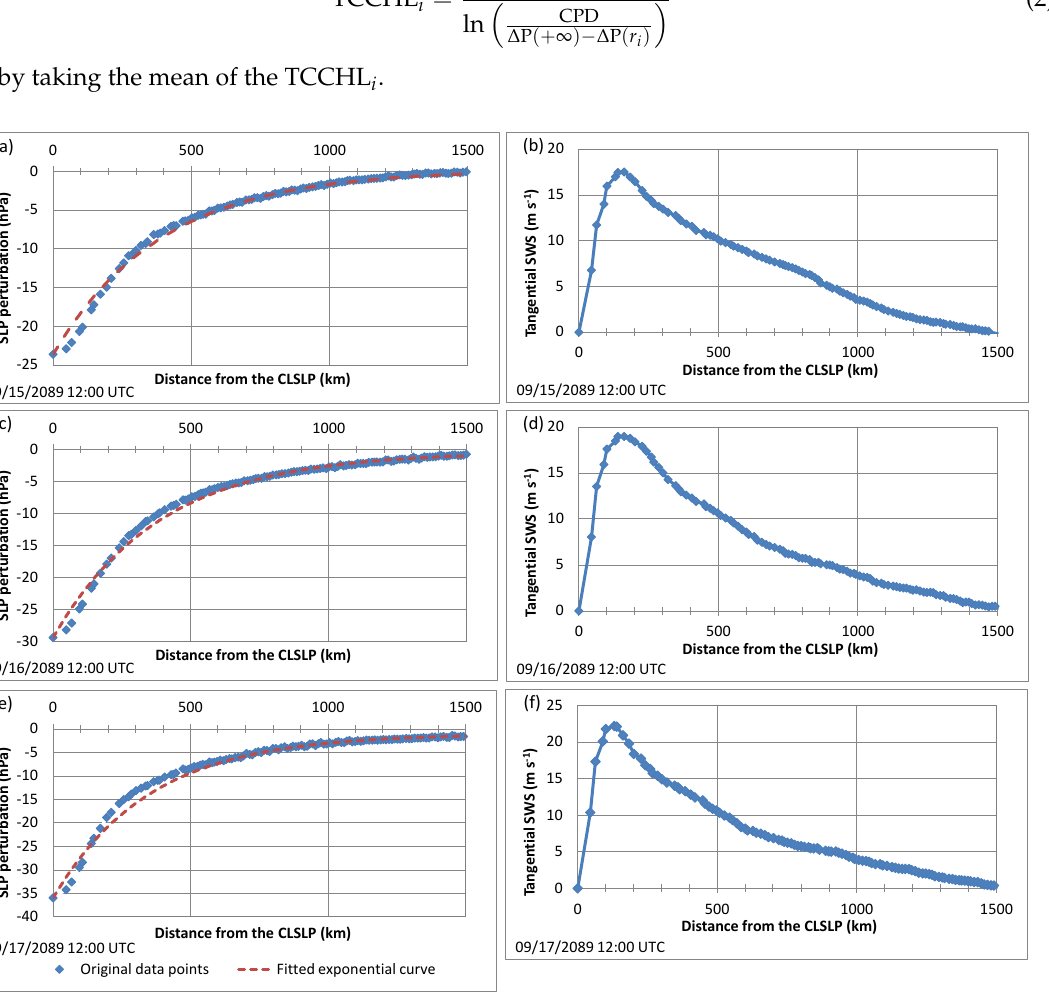
Figure 3. Graphs of the azimuthally-averaged sea level pressure (SLP) perturbation as a function of the distance from the center of low SLP (CLSLP) in a TC in September 2089 for three dates: ( a ) 09/15 12:00 UTC, ( c ) 09/16 12:00 UTC, and ( e ) 09/17 12:00 UTC. The red dashed line corresponds to the fitted exponential curve used to estimate the TC characteristic horizontal length (TCCHL); Graphs of the azimuthally-averaged tangential surface wind speed (SWS) as a function of the distance from the CLSLP in a TC in September 2089 for three dates: ( b ) 09/15 12:00 UTC, ( d ) 09/16 12:00 UTC, and ( f ) 09/17 12:00